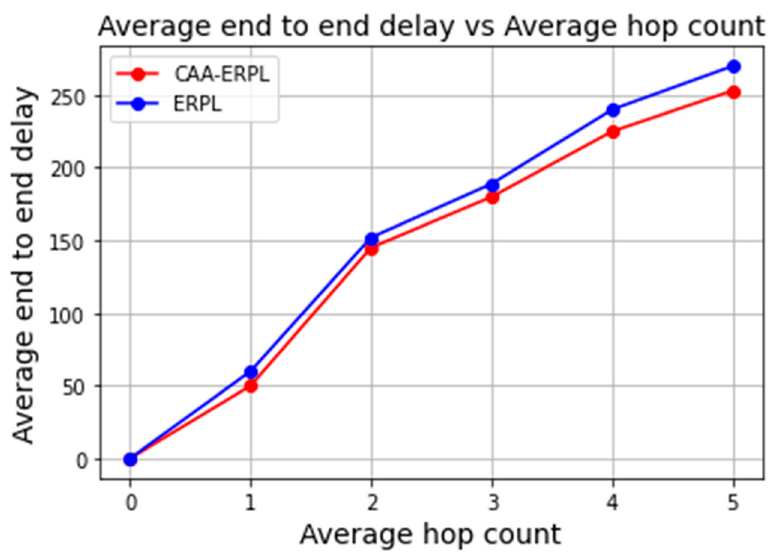
Figure 9. Average end ‐ to ‐ end delay vs. average hop count.